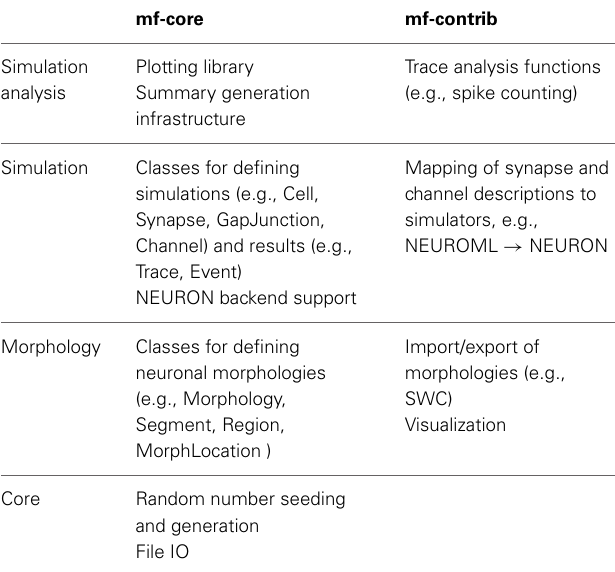
Table 1 | An overview of morphforge’s